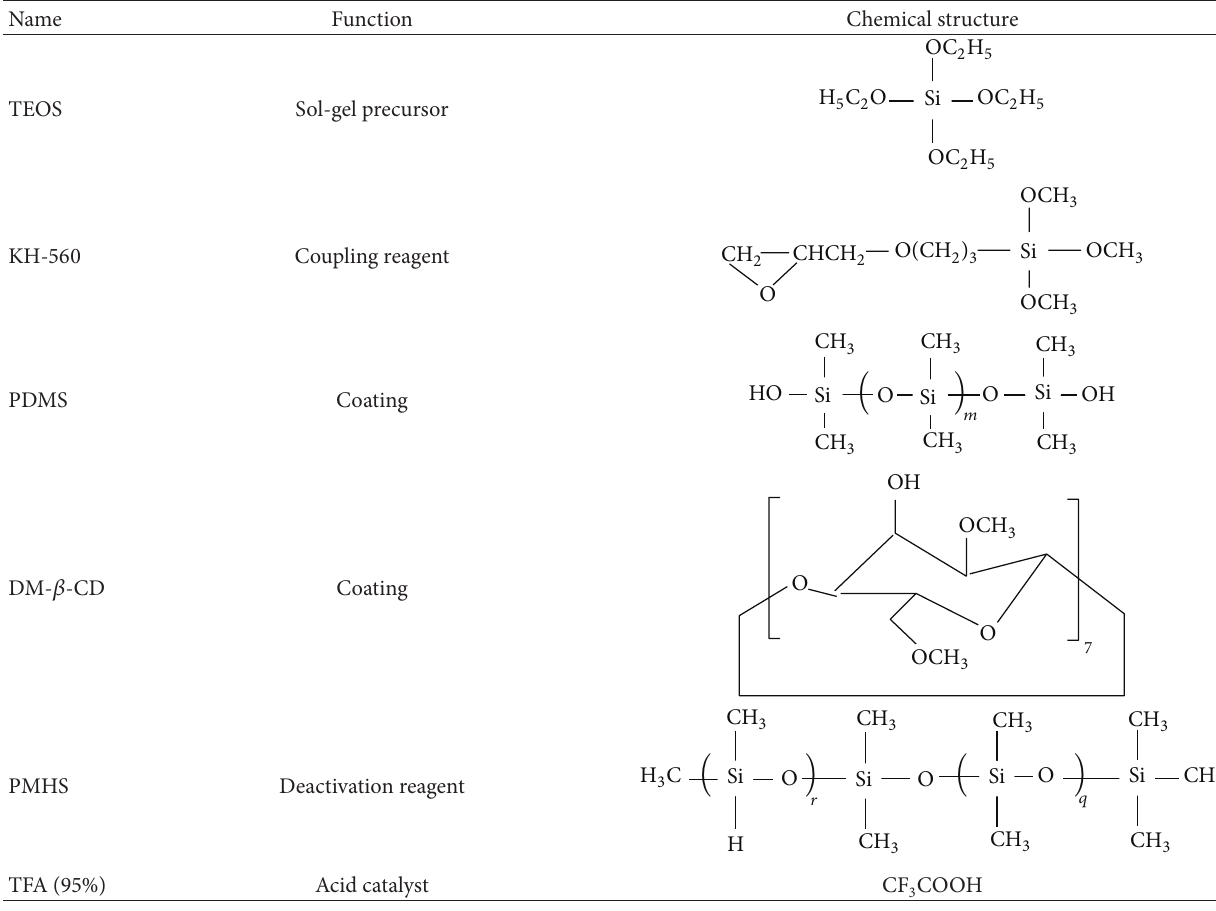
Table 2: Function and chemical structures of the coating solution ingredients for sol-gel-derived DM- 𝛽 -CD/OH-TSO coating